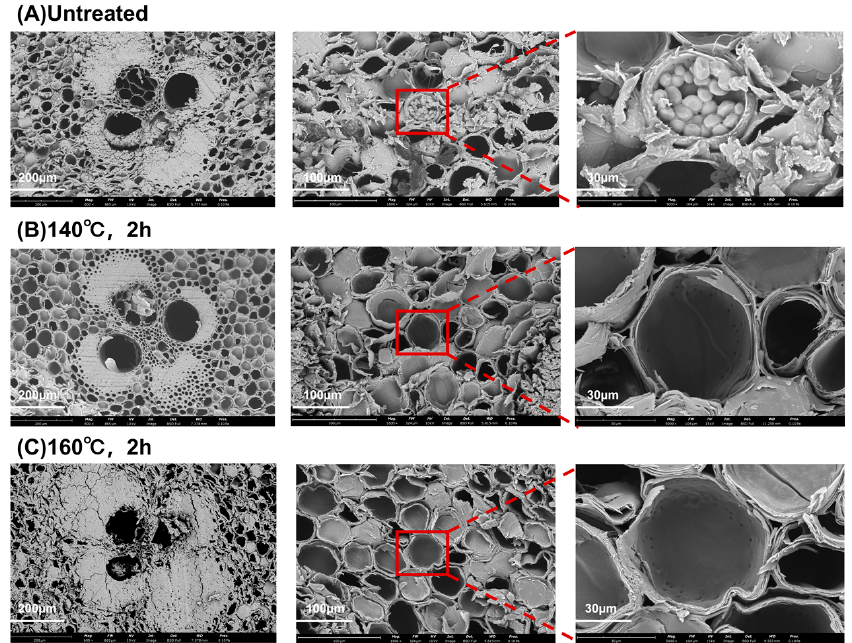
Figure 5. SEM images of bamboo samples hydrothermal treated at different temperatures for 2 h.